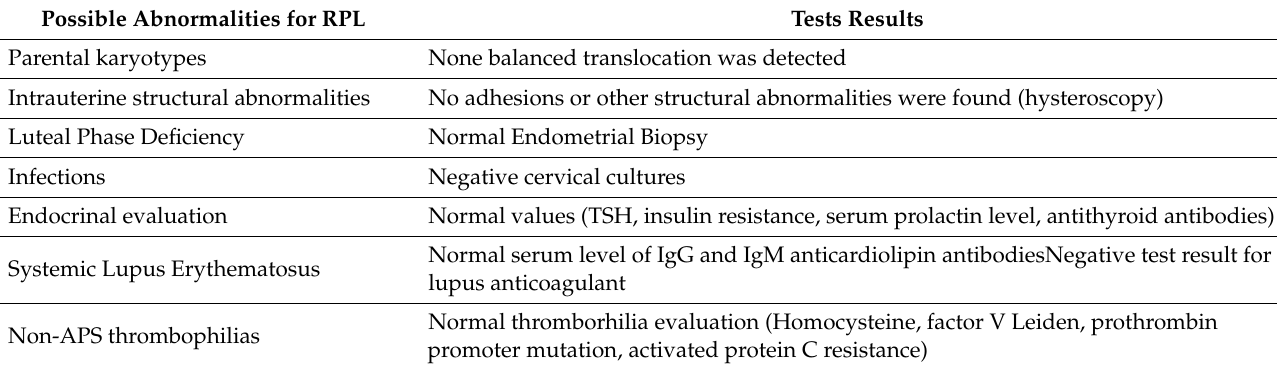
Table 1. Test results to exclude the main abnormalities and known pathogenesis of RPL. Tests